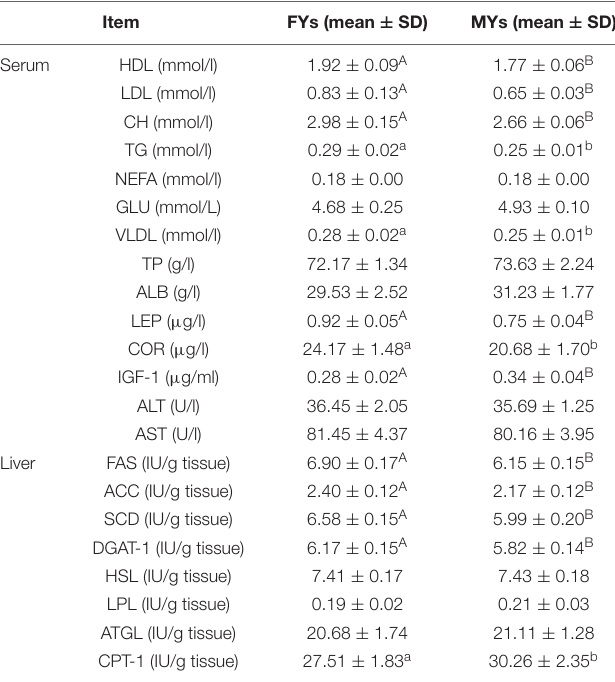
TABLE 2 | Metabolite concentration in serum and enzyme concentration in livers of FYs ( n = 10) and MYs ( n = 10).